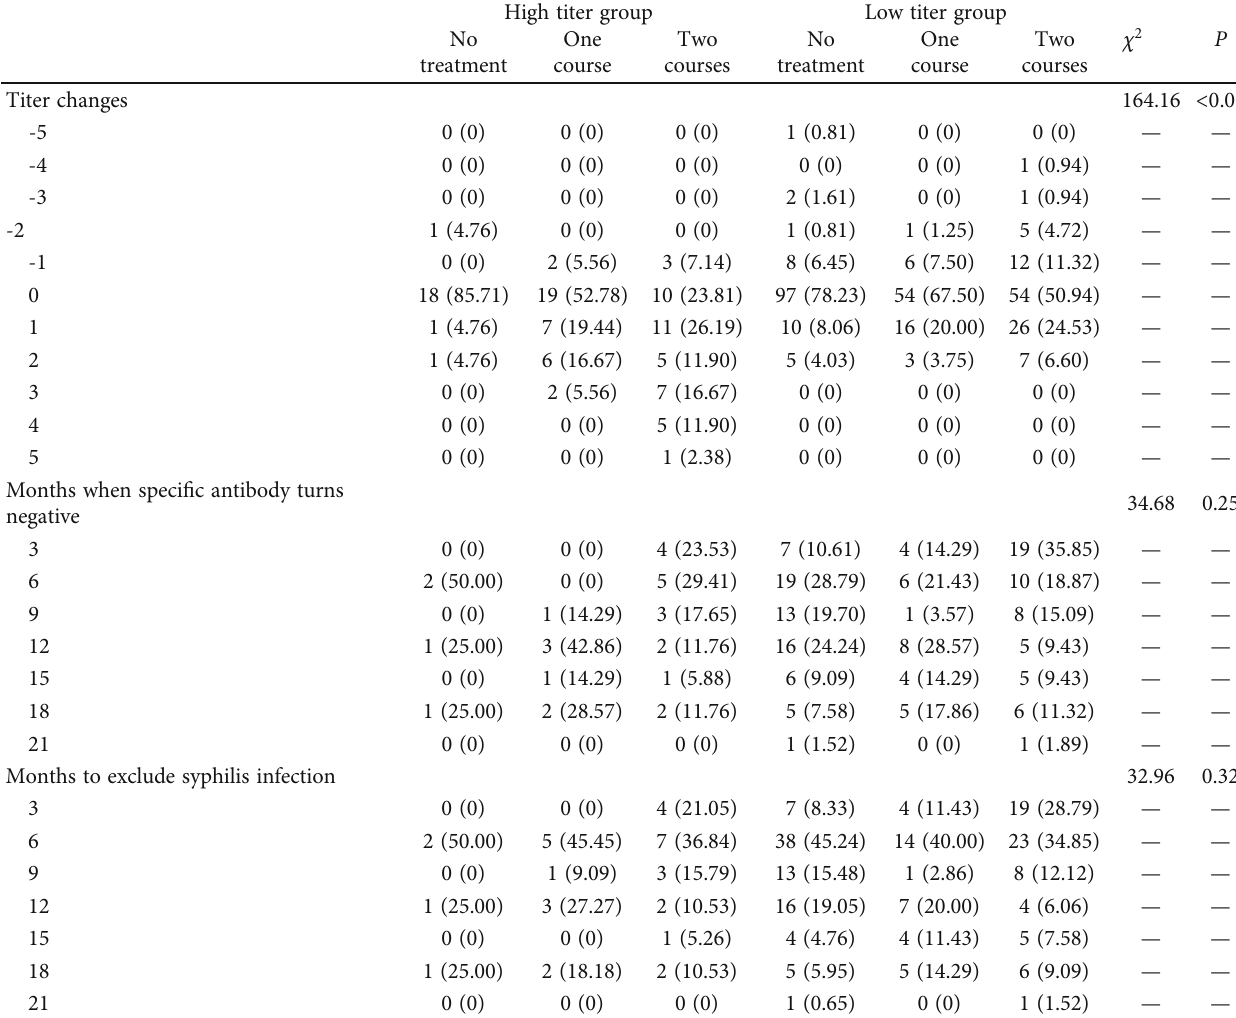
Table 9: Comparison of results features of pregnant women with syphilis with or without treatment during pregnancy between high titer group and low titer